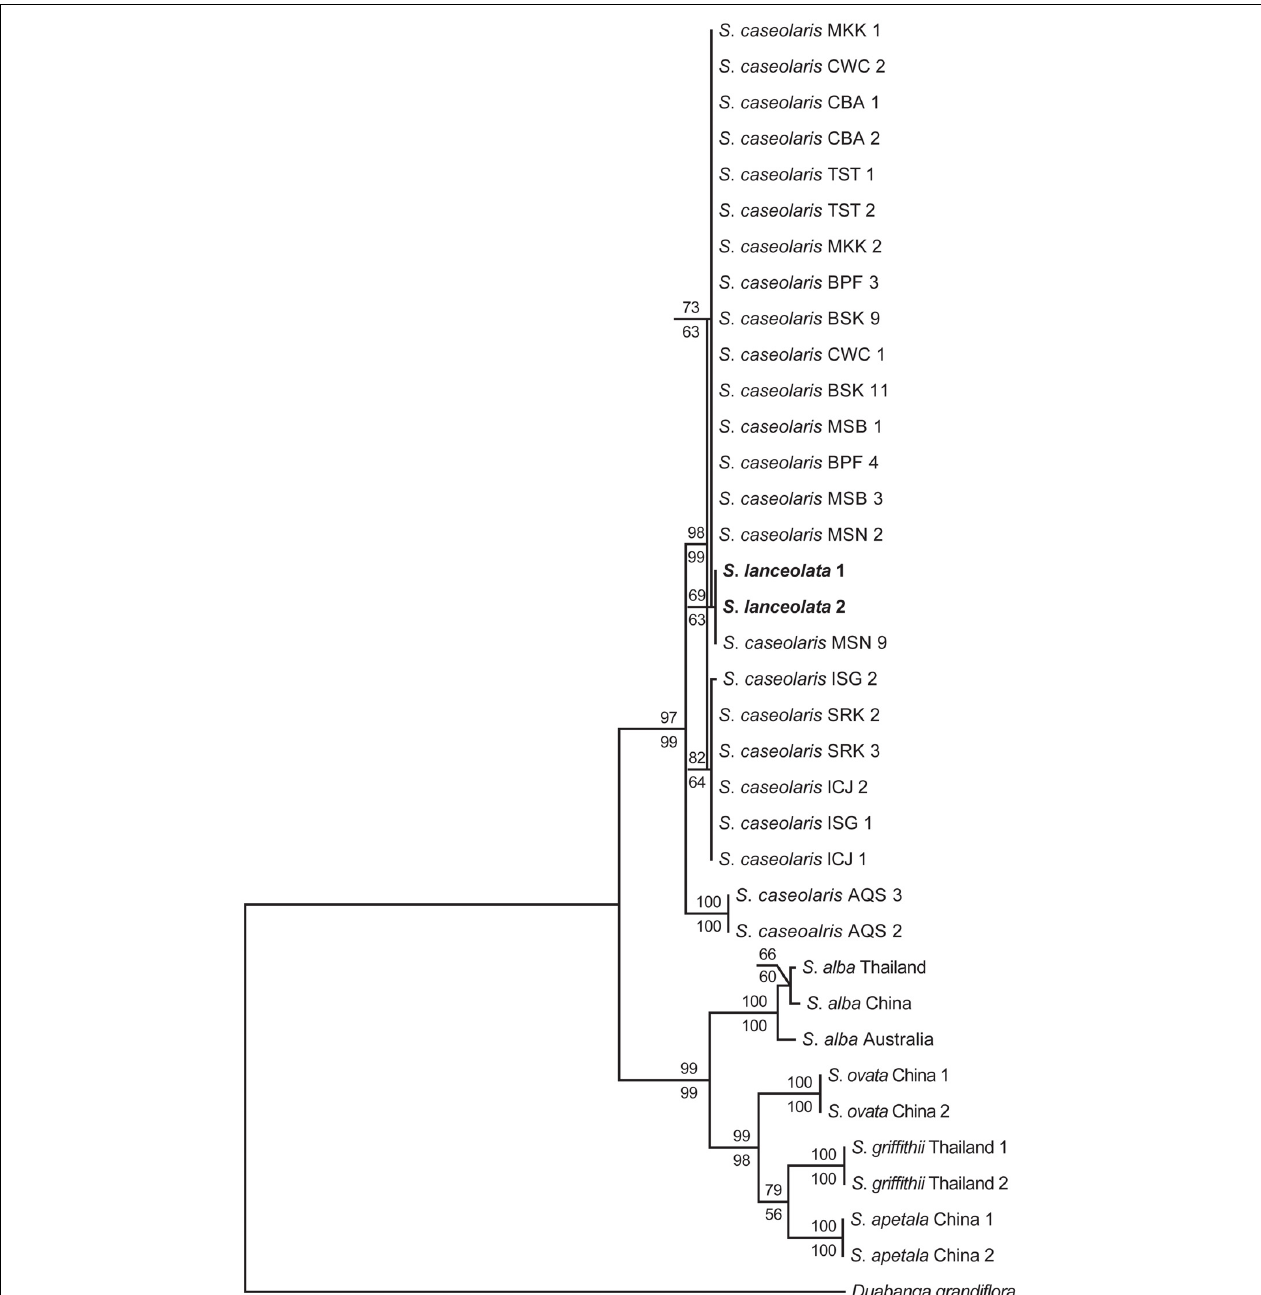
FIGURE 1 | Maximum parsimony (MP) and maximum likelihood (ML) phylogenetic trees of Sonneratia based on the combined sequences of nrITS and one nuclear gene rpl9 . S. lanceolata samples are shown in bold. Numbers up and down the branches are bootstrap values ( > 50%) of the MP and ML analysis, respectively. The abbreviations of the sampling location after species names are listed in Additional file 6: Supplementary Table